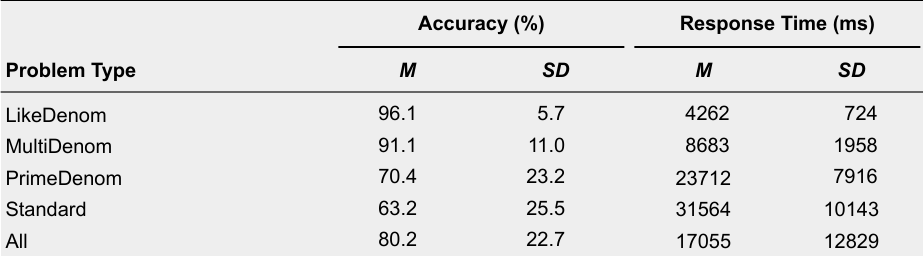
Mean Accuracy and Response Times for Correctly Solved Problems per